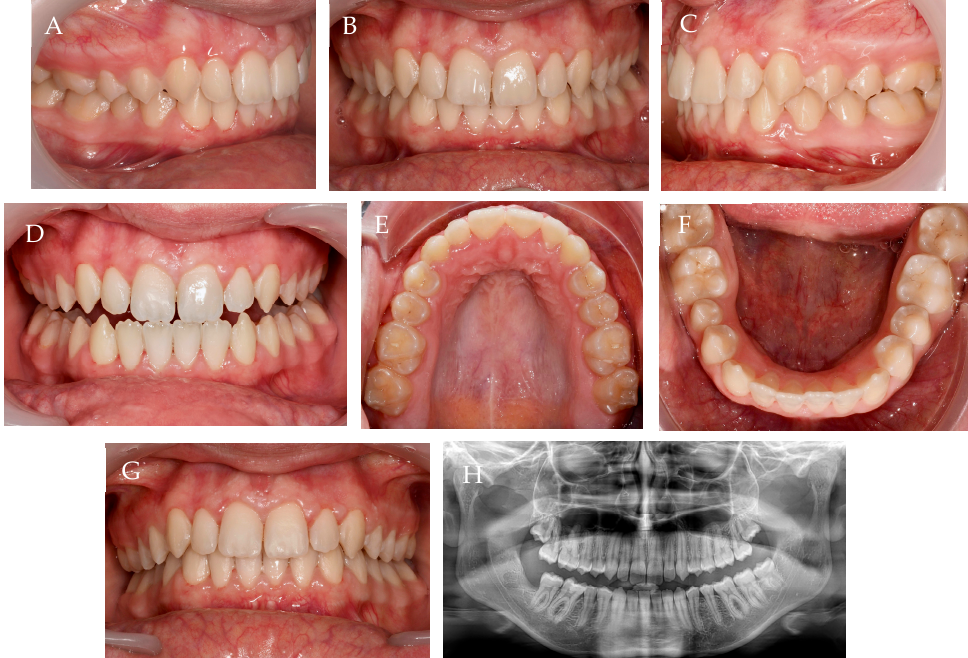
Figure 16. Follow-up, 6 months after treatment end. ( A – C ) intra-oral photos in maximum intercuspation/centric relation; ( D ) protrusive guide; ( E , F ) occlusal photos; ( G ) overjet view; ( H ) panoramic x-ray.